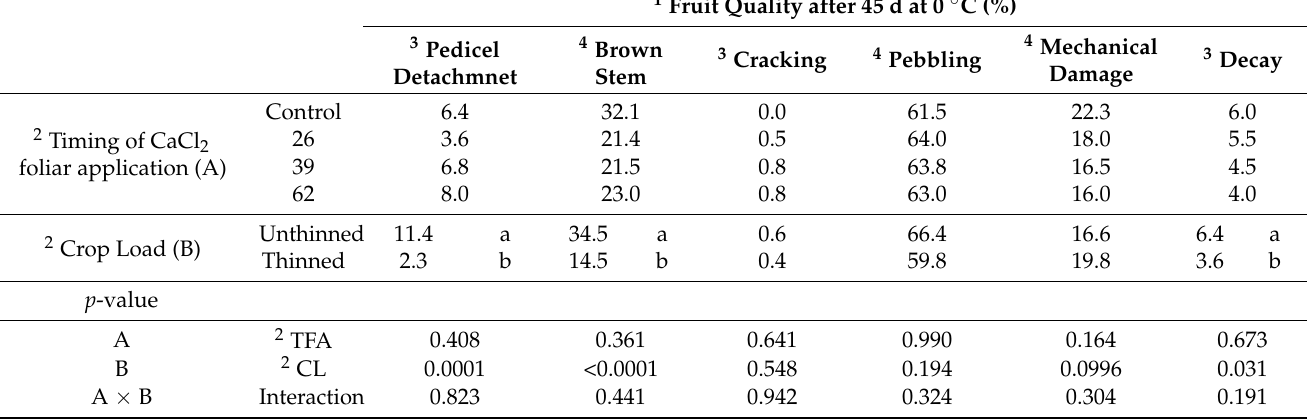
1 Means of 100 fruits/replicate. Different letters in the same column indicate significant differences between the timing of CaCl 2 foliar application (A) based on Tukey’s test ( p ≤ 0.05) or between crop load (B) based on ANOVA fruit: Monilinia spp., Botrytis spp., and Alternaria sp. 4 Brown stem, pebbling, and mechanical damage (pitting and bruising) follows the description of Zoffoli et al.